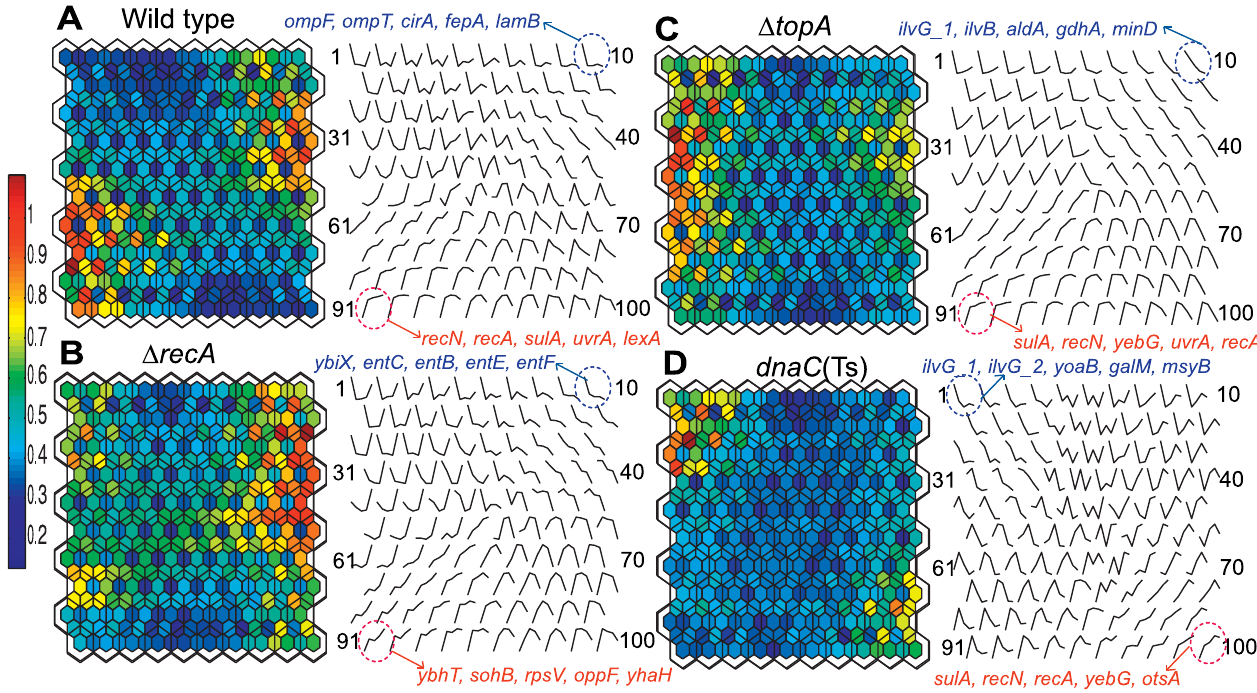
Figure 2. SOM Analysis of Temporal Transcriptional Profiles U-matrix (left side of panel) and weight vectors (right side of panel) of a self-organizing feature map of temporal transcriptional profiles observed after the addition of norfloxacin to the wild-type (A), recA (B), topA (C), or dnaC (Ts) (D) mutant. Transcript levels measured at 5, 10, 15, and 20 min of the treatment were compared with those of the non-treated cells (0 min; first time point) for 1,109 genes that showed differential expression in at least one strain. Each contoured hexagon (left side of panel) has a corresponding weight vector that represents temporal responses (0 to 20 min, right side of panel). Small hexagons indicate map units that are colored according to the medians of the surrounding hexagon with a contour line passing through. DOI: